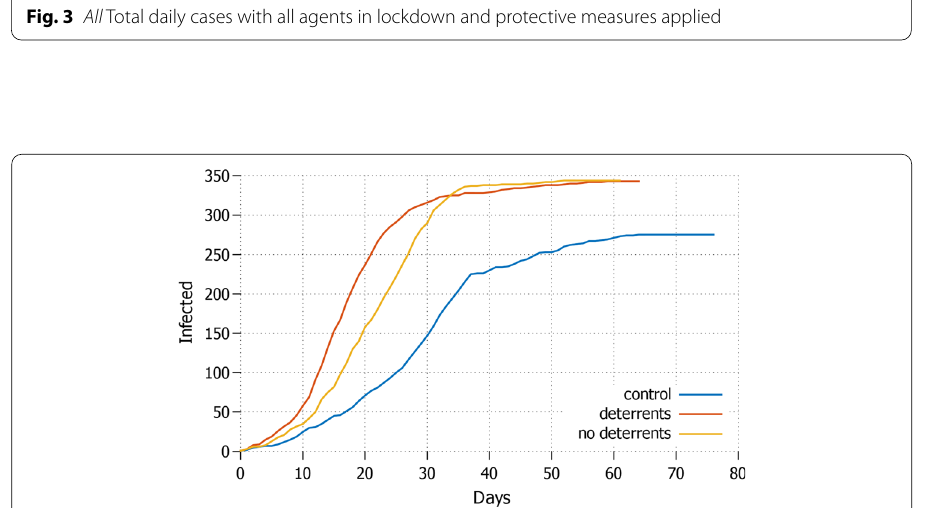
Fig. 4 None Daily increment with no agent in lockdown and protective measures